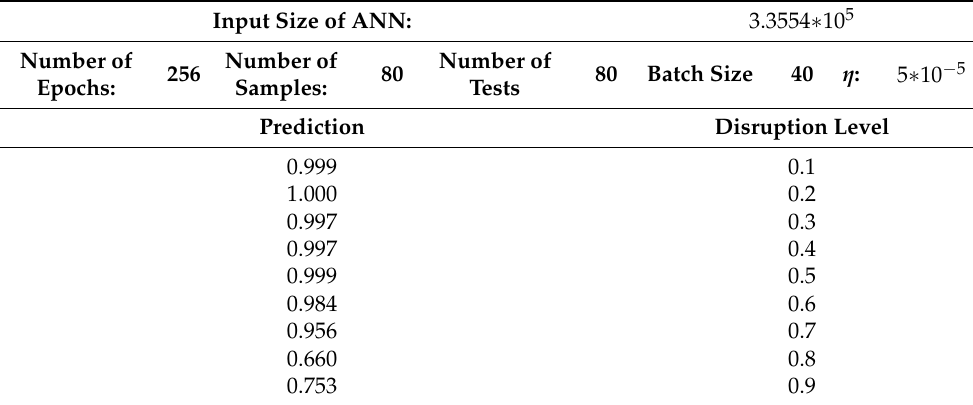
Table 12. Efficiency of signal recognition using the CNN based on a sampled signal in the presence of pseudorandom noise.